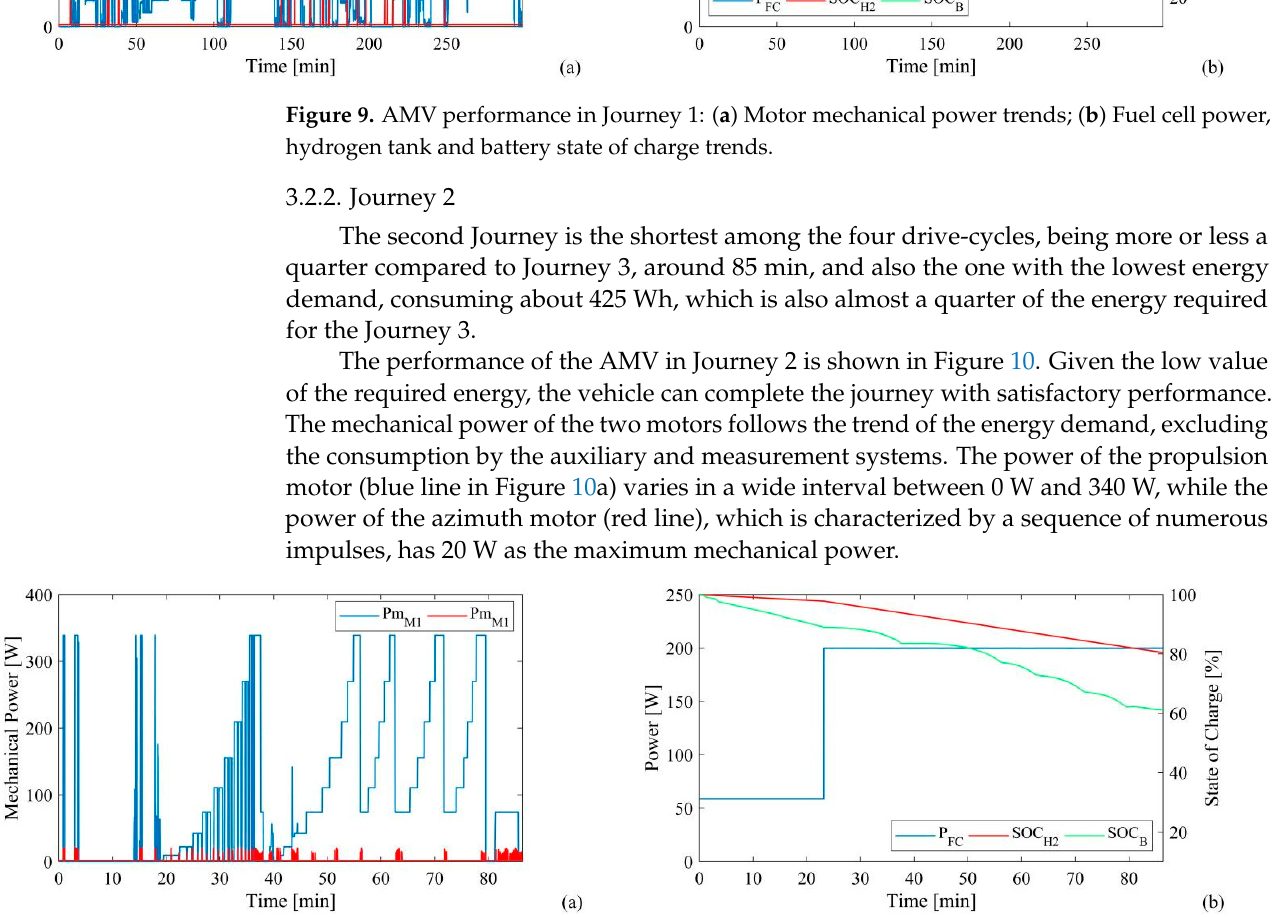
Figure 11. AMV performance in Journey 3: ( a ) Motor mechanical power trends; ( b ) Fuel cell power, hydrogen tank and battery state of charge trends. 3.2.4. Journey 4 The last Journey shows medium values compared to the other cycles, with an energy consumption of 980 Wh. As in the first two cycles, the energy stored on board is sufficient to complete the drive cycle, but a correction of the control system is required for the AMV to complete the journey. In fact, Figure 12 shows the performance of the AMV without corrections and testifies that one of the two SOC limits is reached. This is due to the characteristics of the control strategy and the large difference between the two SOCs; in other words, the hydrogen SOC is much higher than the battery SOC at all times, and the limit conditions are easily reached. Although the hydrogen SOC remains at 55%, the battery SOC reaches the lower limit of 20%, causing the simulation to terminate. The main reason for this behavior is related to the journey features, namely the pronounced and